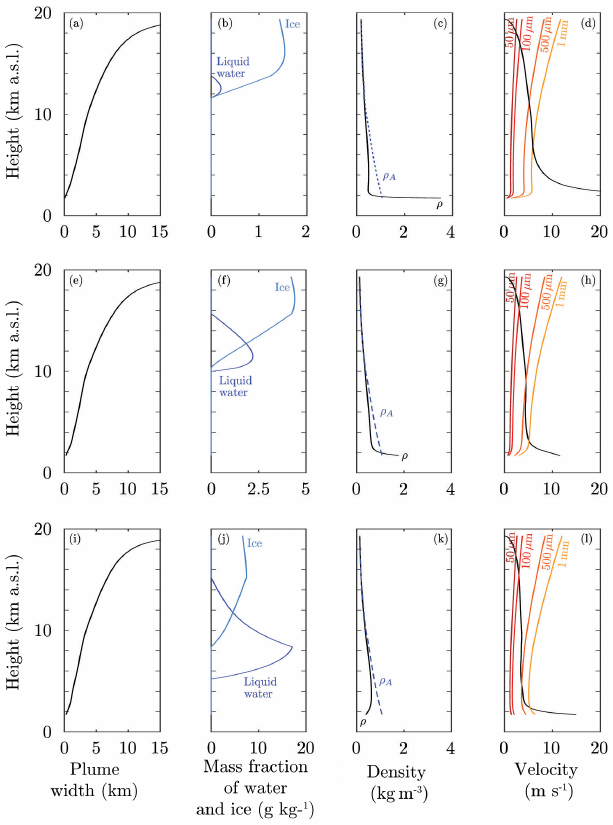
Figure A2. Sensitivity of model predictions of the Grímsvötn plume at 05:00UT on 22 May 2011 to increases in the source water vapour content, with (a–d) n 0 = 0 . 05, (e–h) n 0 = 0 . 10, and (i–l) n 0 = 0 . 15. (a, e, i) Plume width as a function of height. (b, f, j) Mass fraction of liquid water and water ice as a function of height. (c, g, k) Den- sity of the plume ρ p and atmosphere ρ A as functions of height. (d, h, l) Vertical velocity of the plume at the plume edge and critical fallout velocities of 50µm, 100µm, 500µm, and 1mm particles as functions of